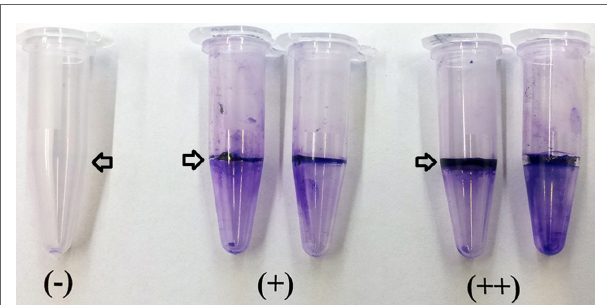
FigUre 3 | Determination of biofilm synthesis was performed using a crystal violet staining method . Measurement of biofilm synthesis was based on color intensity and size of the adherent crystal violet ring with a score ranging from negative ( − ) to strong ( ++ ) biofilm formation. All Bacillus spp. strains were screened by triplicate. Arrows indicate the presence or absence of the biofilm ring.